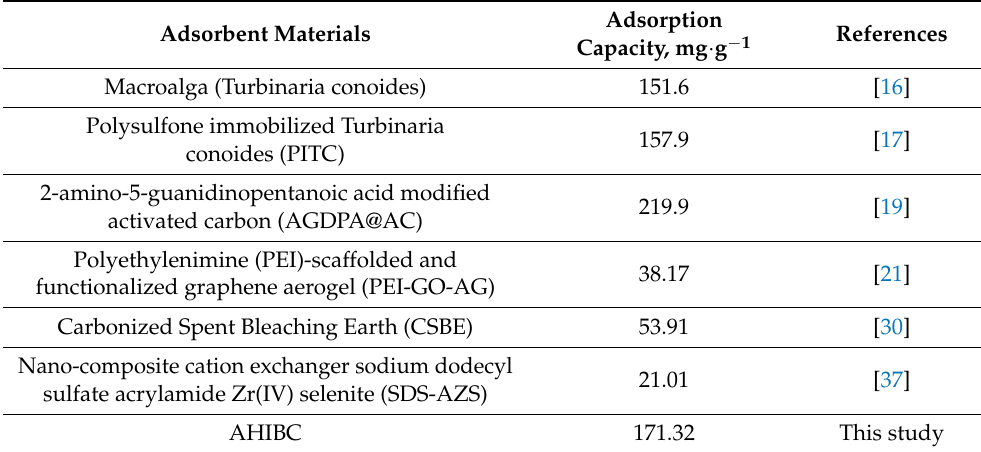
Table 1. Comparison of adsorption capacity of different sorbent